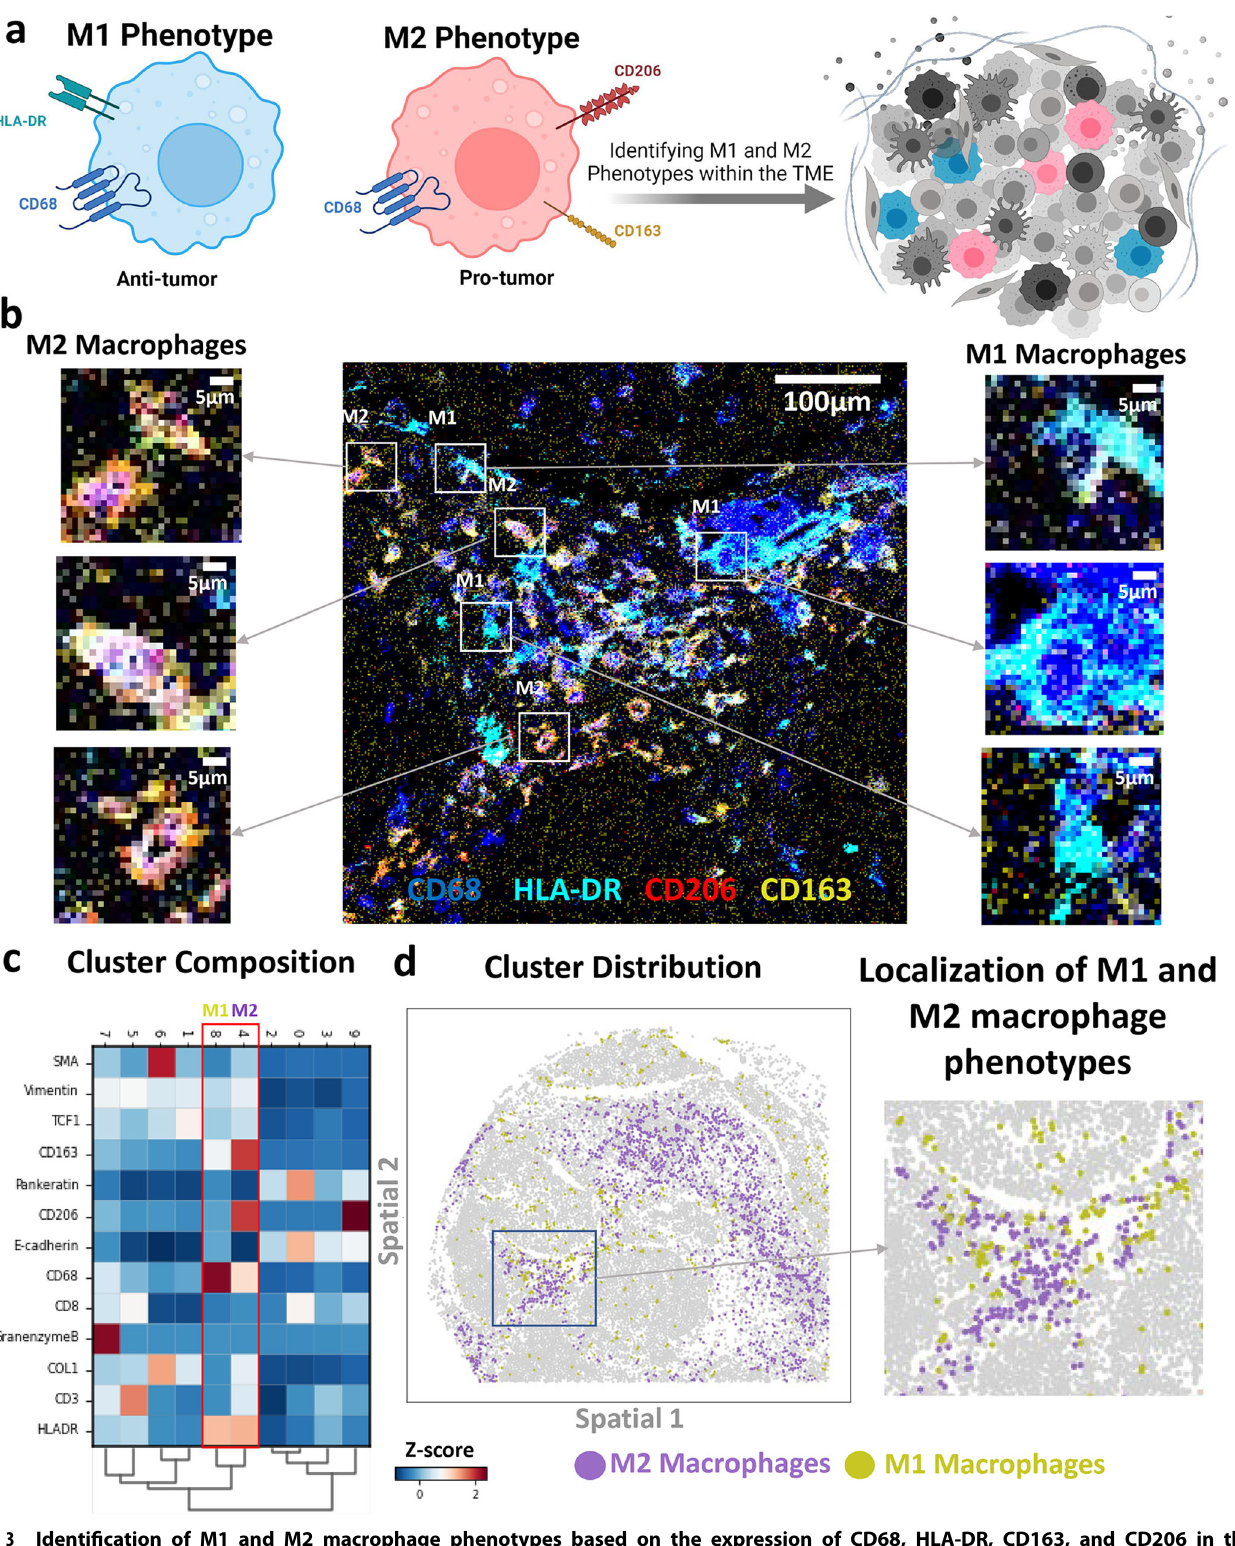
Fig. 3 Identi fi cation of M1 and M2 macrophage phenotypes based on the expression of CD68, HLA-DR, CD163, and CD206 in the multiplexed IMC panel. a Representative schematic highlighting the polarization of macrophages into the anti-tumor M1 phenotype (CD68 + HLA- DR + ) and the pro-tumor M2 phenotype (CD68 + CD163 + CD206 + ). Both phenotypes occupy the tumor microenvironment and impact the overall disease prognosis. Created with BioRender.com. b Representative IMC images present the expression of CD68 in blue, HLA-DR in cyan, CD206 in red, and CD163 in yellow. CD68 and HLA-DR were chosen to identify M1-polarized macrophages whereas CD68, CD163, and CD206 were used to identify M2-polarized macrophages. c Correlation heatmap yielded the co-expression of markers across the different clusters. The macrophage M1 phenotype cluster showed the expression of CD68 and HLA-DR whereas the macrophage M2 phenotype showed the expression of CD68, CD163, and CD206. d Cluster distribution map demonstrated the interaction and localization between M1 and M2 clusters on an example cancer tissue